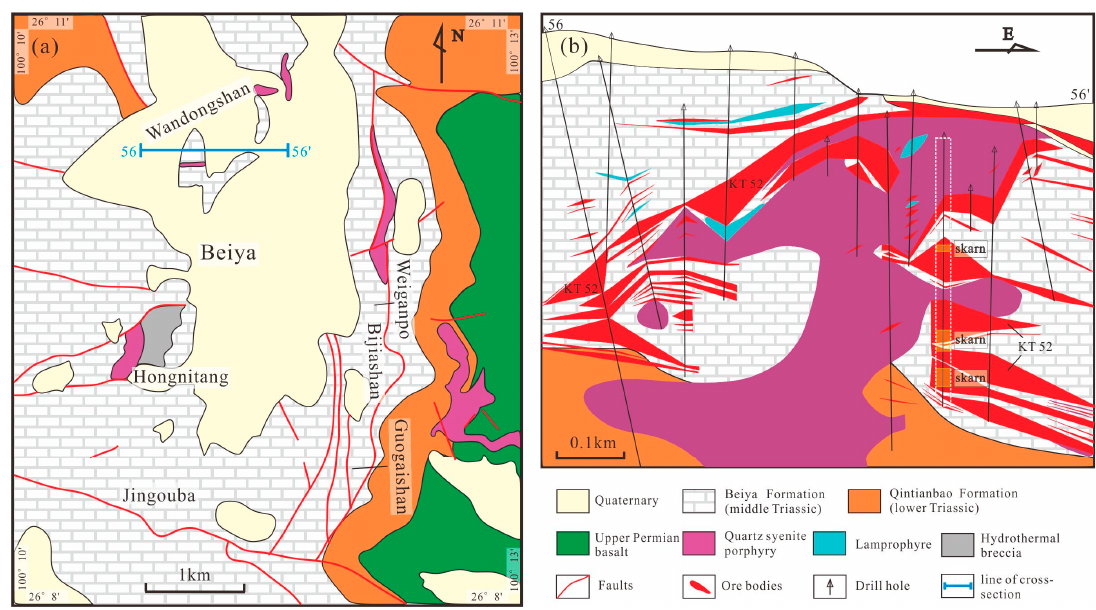
Figure 2. Geological map ( a ) and cross-section ( b ) of the Beiya deposit. Modified after [30,46].